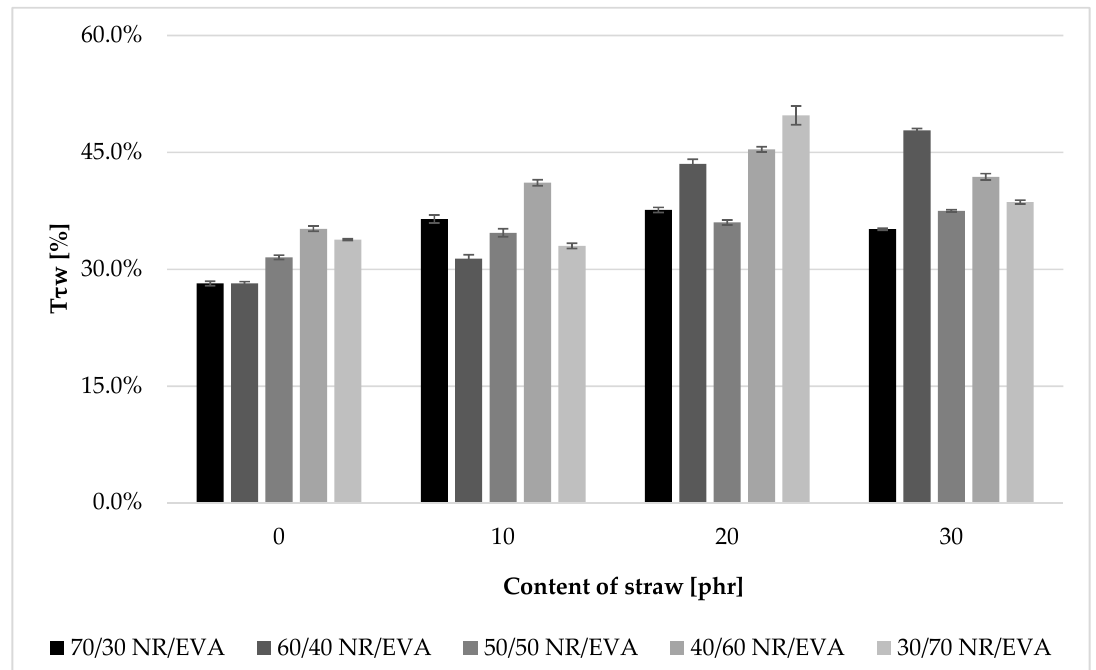
Figure 3. The relative damping factor of unfilled and filled with straw natural rubber/ ethylene–vinyl acetate copolymer (NR/EVA) blends.